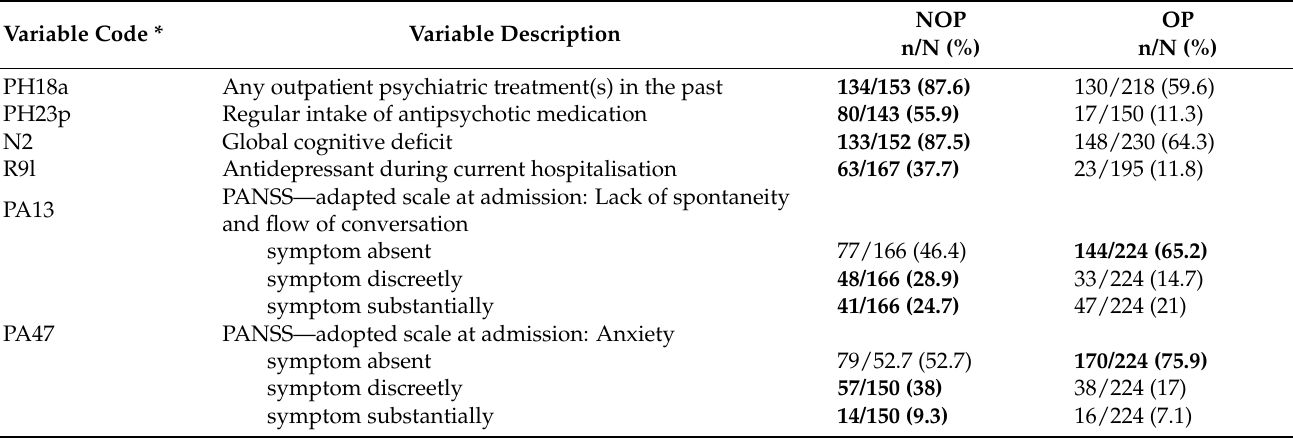
Table 3. Absolut and relative distribution of predictor variables most dominant in the